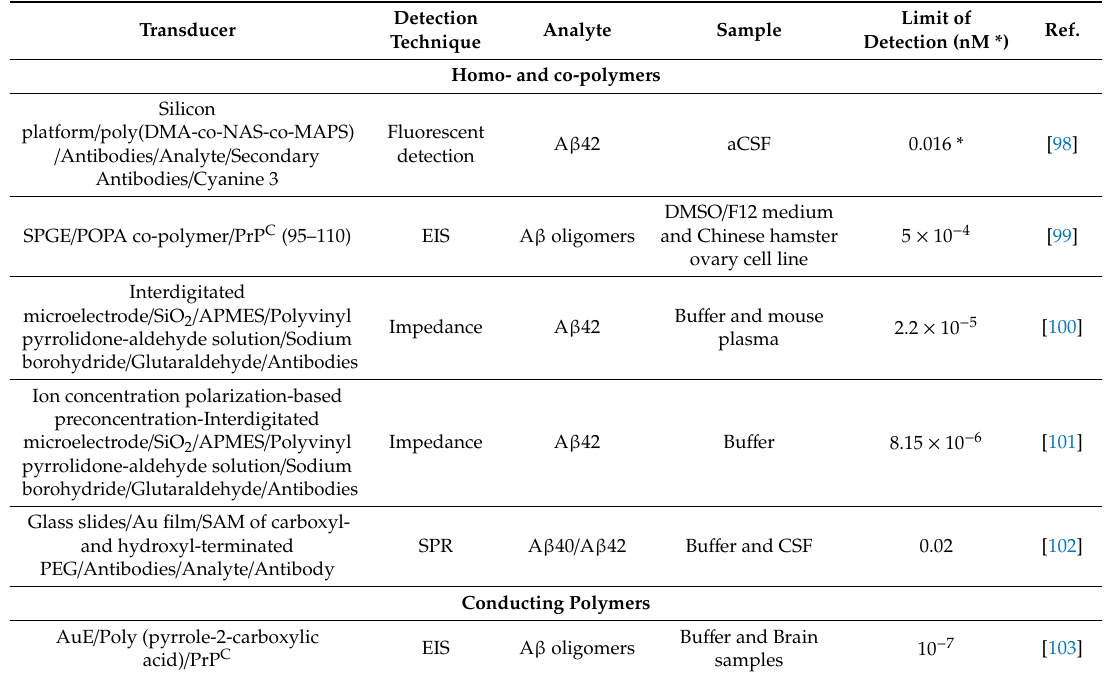
Table 3. Biosensors-based polymers for determination of AD biomarkers.